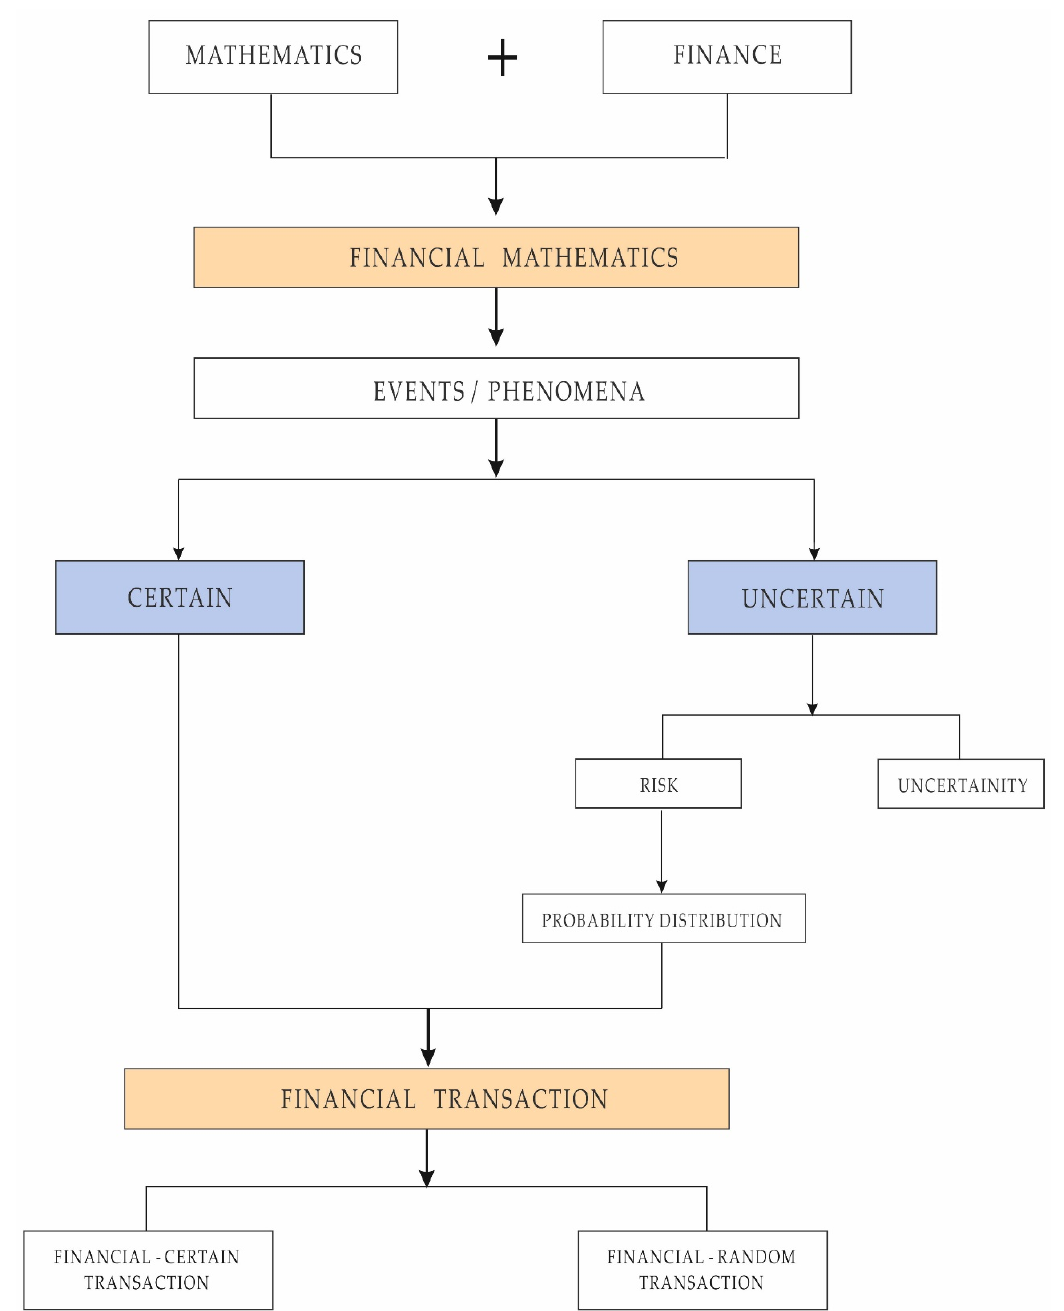
Figure 1. Conceptual framework of the research.